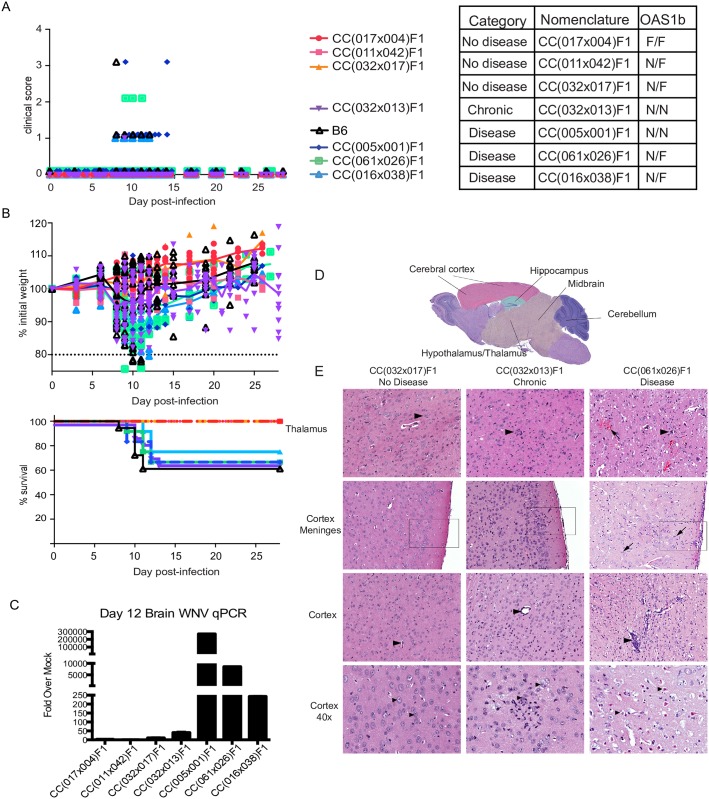
Comparison of WNV disease models by clinical presentation and neuropathology.(A) Representative RIX lines for 3 WNV disease model categories: 1) No disease 2) Chronic disease and 3) Disease. Representative “No Disease” and “Disease” lines were selected from 40+ lines of each category, identified through the screen. Each RIX line’s CC nomenclature and Oas1b allele status is shown (N = null, F = functional allele). Clinical scores and (B) weight loss and survival curves are shown for the seven CC RIX lines over the time course of WNV infection. “No disease” RIX show little to no weight loss and maintain a “0” clinical score across the time course. “Disease” RIX lines show increased weight loss by d8, as well as increase in clinical scores corresponding to neurological weakness and paralysis (see description in methods). (C) Brain WNV loads at d12 for the seven lines. p<0.001 for CC(032x013)F1 compared to all disease lines. (D-E) Neuropathology of WNV infection in RIX lines as indicated. (D) The approximate subregions of the brain that were scored for neuropathology are colorized. These regions were chosen due to the quality and consistency of the sections across the high throughput histologic study. (E) Hematoxylin and eosin stained sections of formalin-fixed paraffin-embedded tissues of WNV-infected lines as indicated with subregion noted. Thalamus: Arrows indicate neurons. In the Chronic and Diseased tissues, the neurons are surrounded by glia (satellitosis). In the Disease tissue there is moderate hemorrhage (arrow), diffuse gliosis and mild malacia. Cortex Meninges: In the Chronic and Diseased boxed region there is gliosis in the superficial cortex with mononuclear cell infiltrate in the meninges, which is more pronounced and widespread in the Diseased tissue. There are prominent mononuclear cells with rod-shaped nuclei in the Diseased cortex (arrows) are consistent with activated microglia. Cortex: Arrowheads indicate blood vessels. In the Chronic and Diseased tissues there is mild to marked accumulation of mononuclear inflammatory cells in the vessel wall and perivascular space. In the Disease tissue there is moderate diffuse gliosis and perivascular cuffing. Cortex 40X: Arrowheads indicate neuron cell bodies. In the Chronic tissue, there are glial nodules and early degeneration of neurons with mild malacia. In the Disease tissue the neurons are shrunken with dark eosinophilic cytoplasm, and pyknotic nuclei consistent with acute neuronal degeneration to apoptosis (left arrow). Note karyorrhectic debris (small basophilic bodies). All panels 20X except where indicated. Data represent three mice per group for all lines in the screen, and six mice per group for d28 and d60 validation time points.